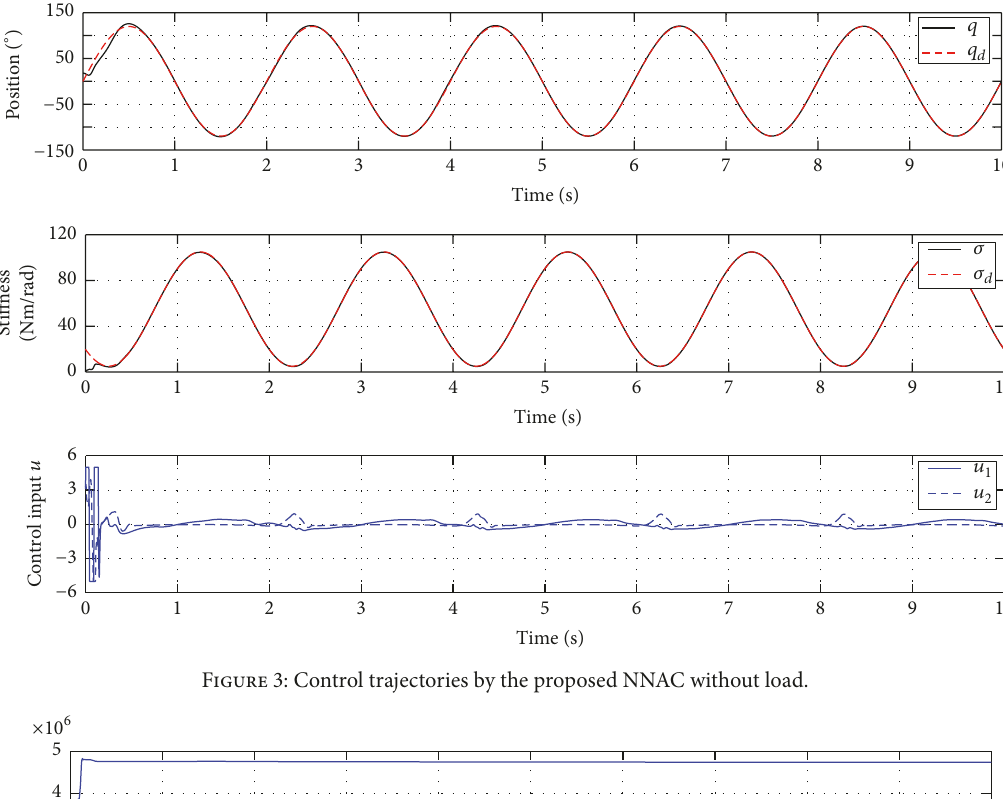
Figure 3: Control trajectories by the proposed NNAC without load.